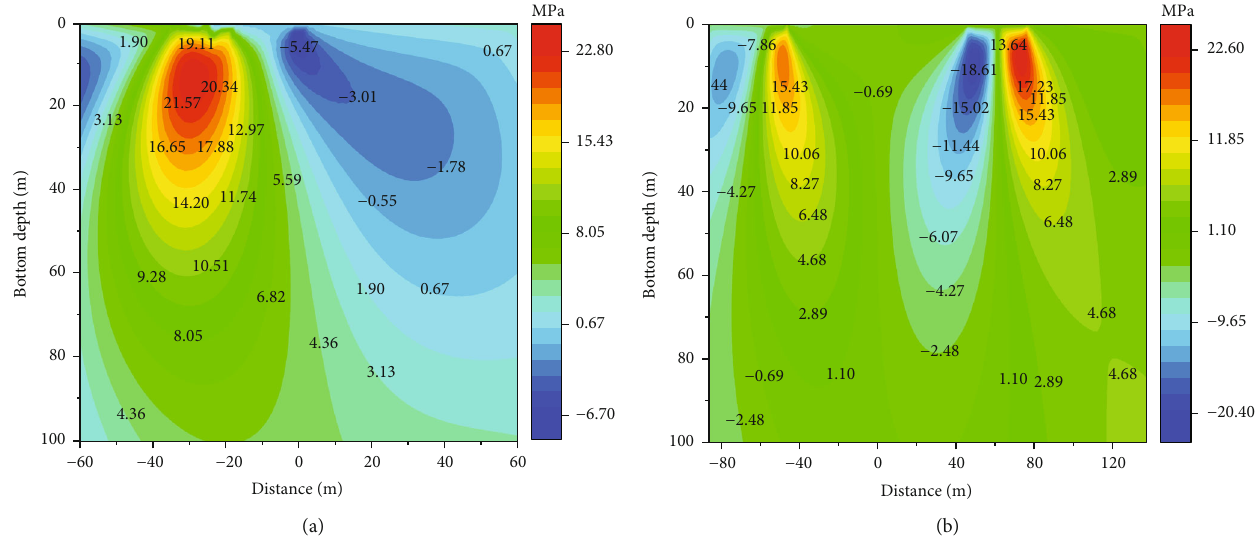
Figure 8: The isoline of the shear stress: (a) along the inclination; and (b) along the strike.